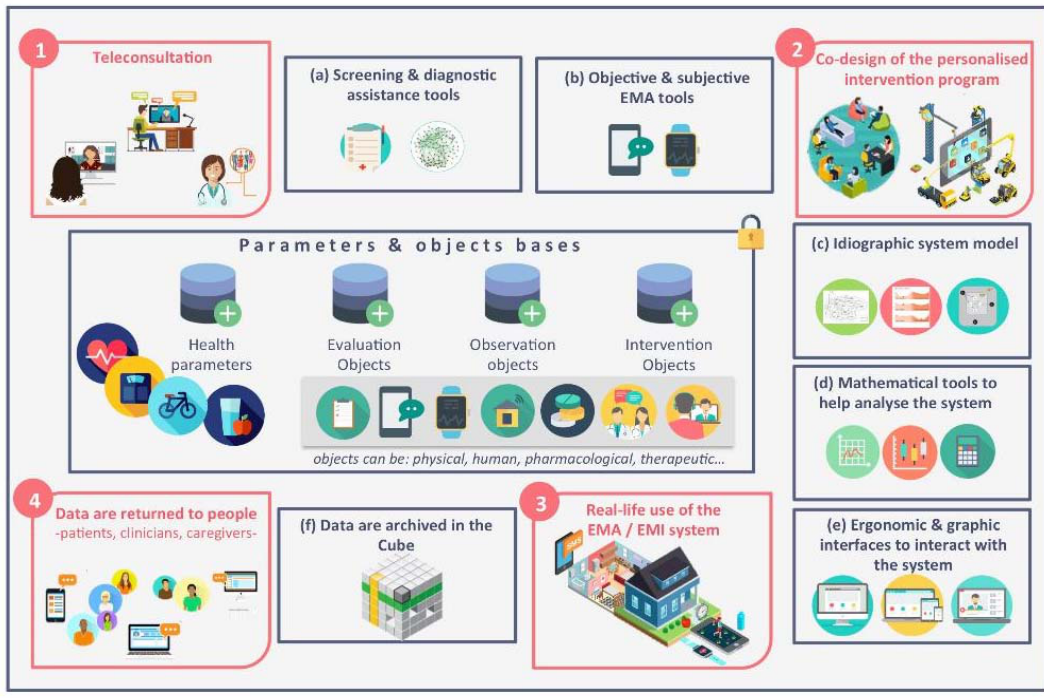
Figure 1. Design and use processes of a device for a Technologically Augmented Clinical and Therapeutic relationship.